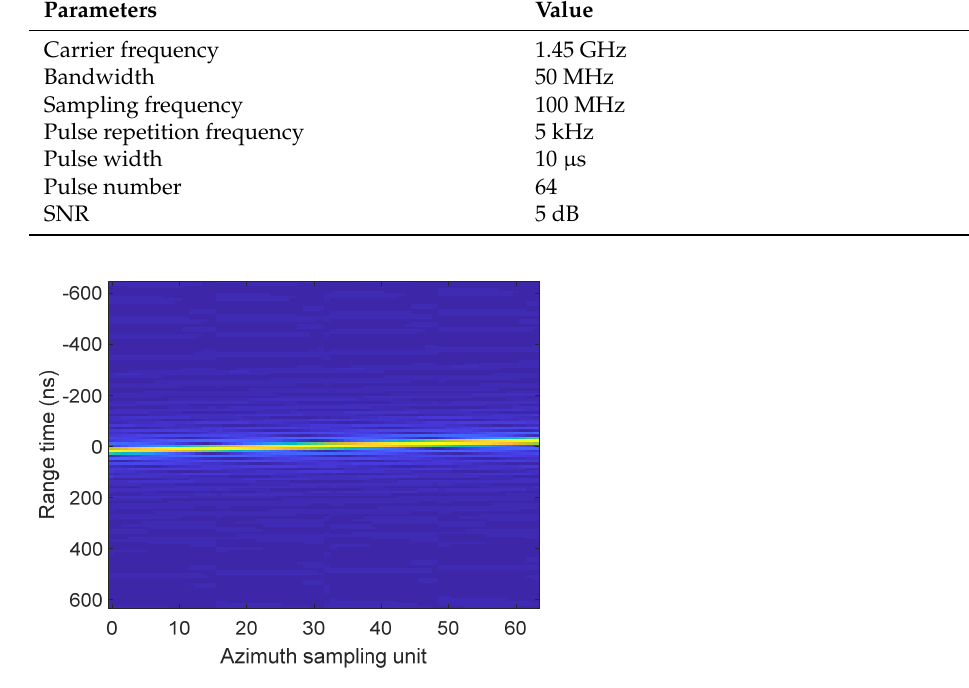
Figure 6. Result of a raw data-based method of Receiver #1. After the transformation, a horizontal straight line, as shown in Figure 7, is obtained. The range frequency and azimuth time are decoupled, and the data are well compressed in the azimuth